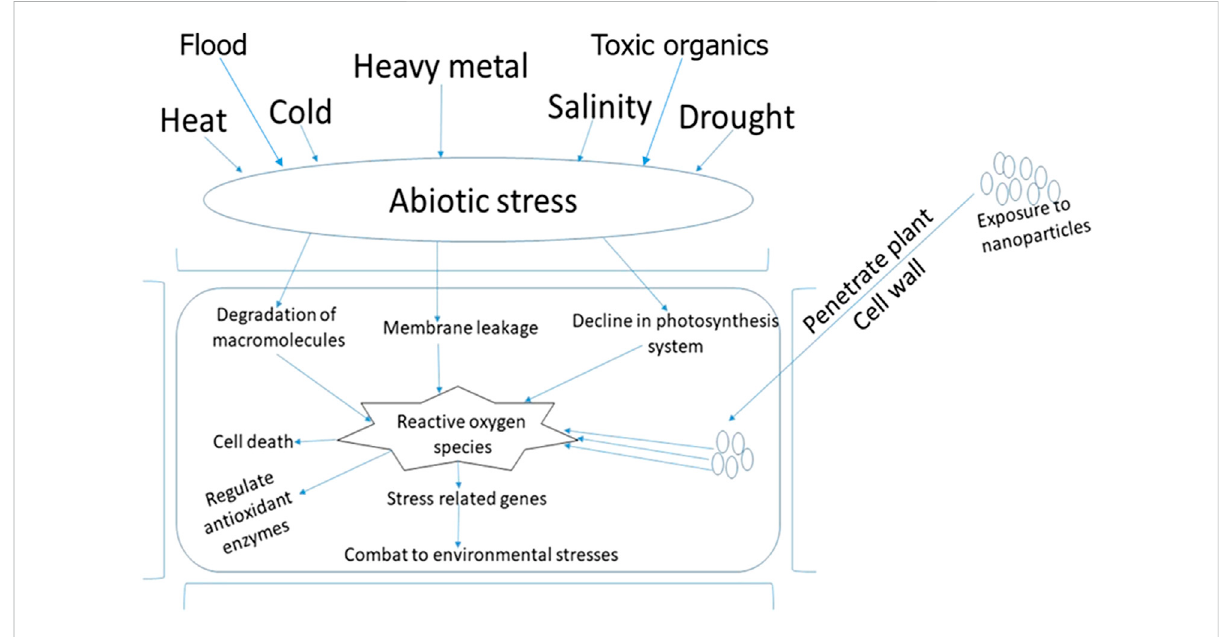
FIGURE 2 The use of nanotechnology to suppress abiotic stress conditions in a plant